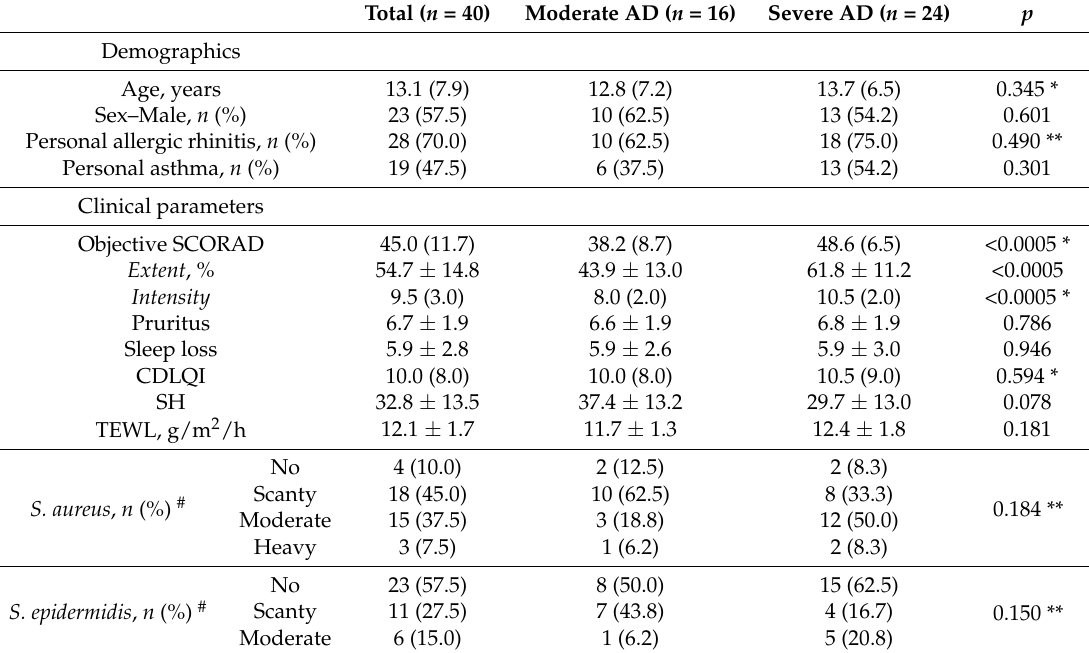
Table 1. Demographics and clinical parameters of patients with moderate and severe AD.